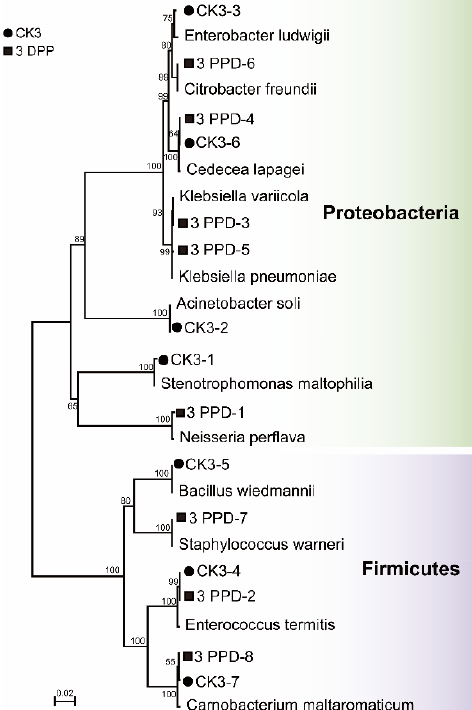
Figure 7. Neighbor-joining tree of bacterial isolates from parasitized and non-parasitized P. xylostella and their closely related species based on sequencing of the 16S rDNA gene. The nodes’ bootstrap values were based on 1000 replicates. The scaled bar represents 0.02 estimated phylogenetic divergence.